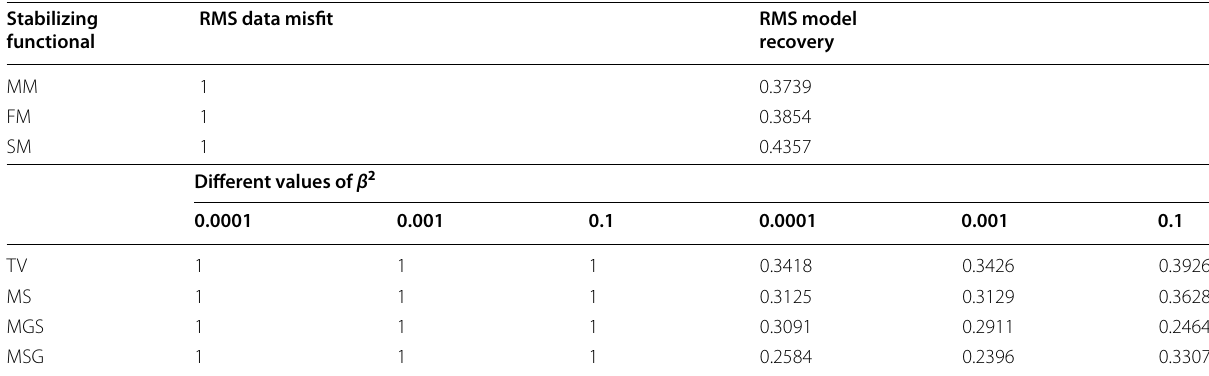
Table 3 RMS data misfit and RMS model recovery of different stabilizing functionals for the 1D-layered model B (Fig. 2b) Stabilizing